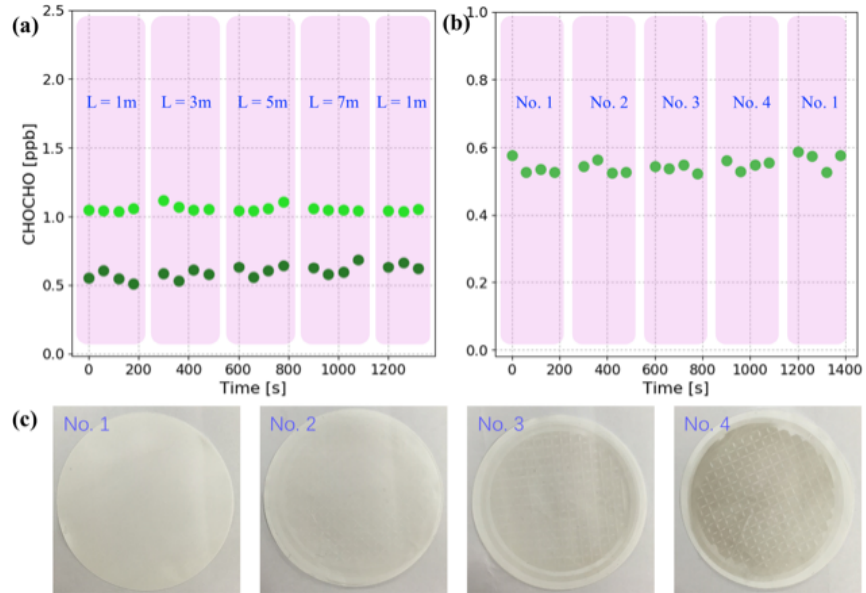
Figure 5. Sample loss experiments: (a) two sets of GLY concentrations (light green dots and dark green dots) measured with different lengths of sampling line ( L ). Each pink overlay represents the concentrations measured with the same length of sampling line. (b) GLY concentrations measured using particle filters with different levels of cleanliness, which are marked as no. 1, no. 2, no. 3, and no. 4. Each pink overlay represents the concentrations measured with the same filter. (c) Samples of the four particle filters corresponding to (b) ; the daily average concentrations of PM 2 . 5 corresponding to these filters are 0 (new filter), 11, 37, and 83µgm − 3 ,